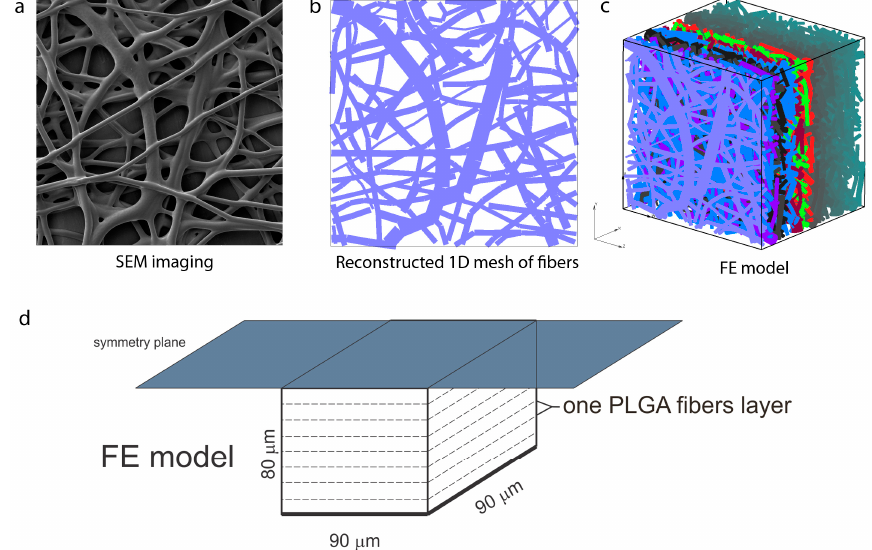
Figure 7. Configuration of the finite element (FE) model of PLGA implant, ( a ) SEM imaging of one layer of PLFA fibers, ( b ) reconstructed 1D mesh of fibers (scan bar 20 µ m), ( c ) reconstructed FE model, ( d ) configuration and geometry of FE model [22]. Copyright 2017. Reproduced with permission from the Journal of the Serbian Society for Computational